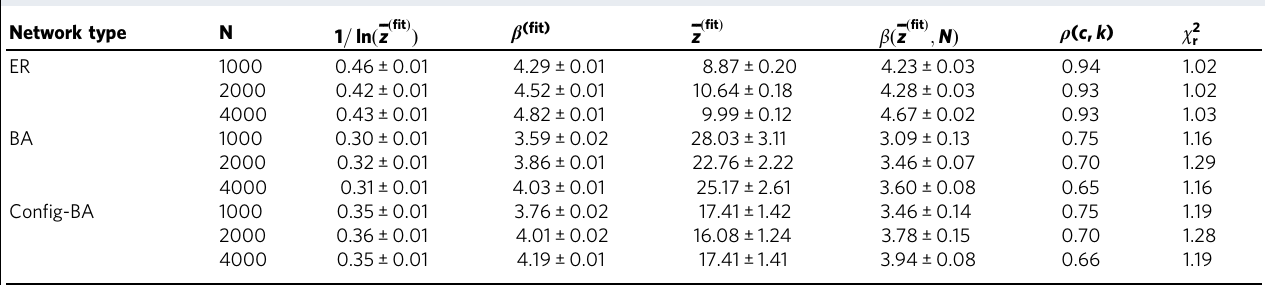
Table of results for one example of a simple graph with average degree 10.0 produced using one of three arti fi cial models with the same average degree 〈 k 〉 = 10.0 but with a different number of nodes, N .Each ‘ ER ’ networkisa standardErd ő s-Réyninetwork,a ‘ BA ’ networkisproduced usingpurepreferentialattachmentintheBarabási-Albertmodel,andthe ‘ Con fi g-BA ’ networkisa con fi gurationmodel version of a Barabási-Albert model network. The results for 1 = ln ð (cid:1) z ð fit Þ Þ and β ( fi t) come from linear fi ts of inverse closeness, 1/ c v to the logarithm of degree, ln ð k v Þ for each vertex v , i.e., 1 = c v ¼ ð ln ð (cid:1) z ÞÞ (cid:2) 1 ln ð k v Þþ β (Eq. (5)). The value of β derived from (cid:1) z ð fit Þ and N using Eq. (6) is also shown for comparison. The fi ts are very good as indicated by the column for the reduced chi-square χ 2 r . The Pearson correlation measure between closeness and degree ρ ( c , k ) is given for comparison with earlier